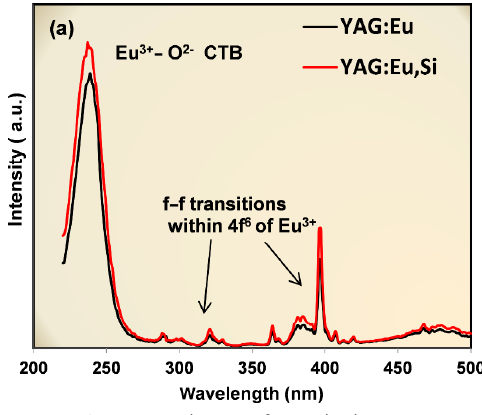
Fig. 6 SEM micrographs of the as-prepared phosphors: (a) YAG:Eu, (b) YAG:Eu,Si.